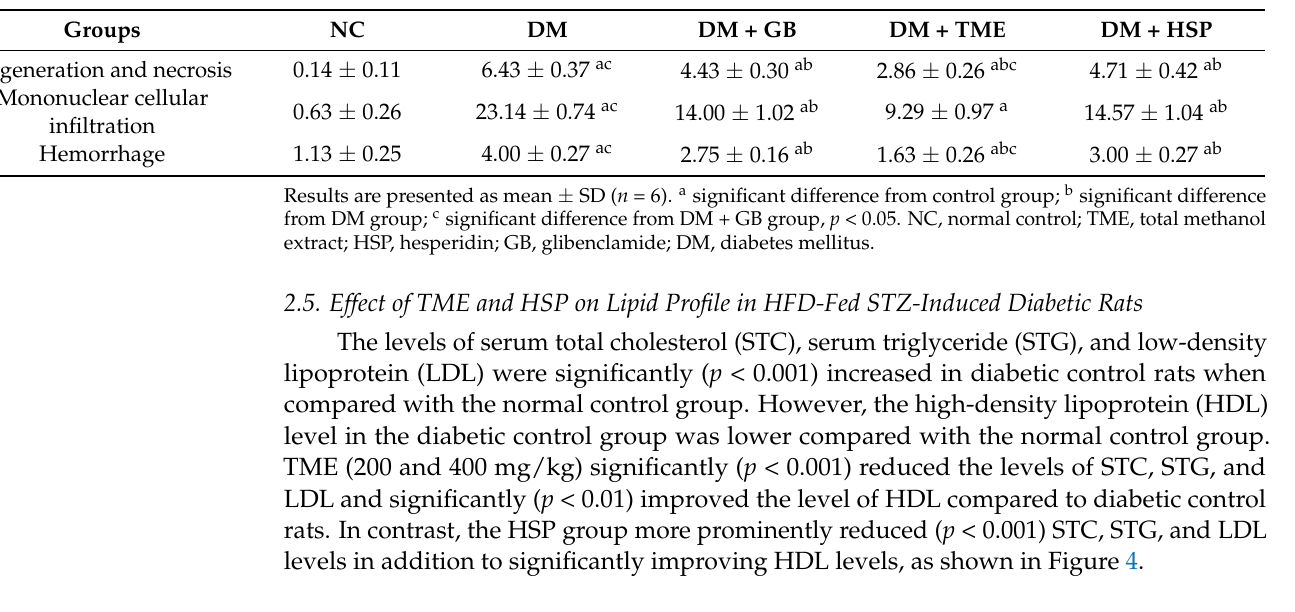
Figure 3. Photomicrographs of control and induced diabetic rat pancreas sections with or without treatment. ( A ) Control rat pancreas (NC) showing normal (exocrine) pancreatic acinar lobules (yellow arrow) and islets of Langerhans (white arrow) embedded within the exocrine portions with vacuolation (brown arrow) and normal intralobular ducts (green arrow). ( B ) Induced diabetic (DM) rat pancreas revealing pathological changes in exocrine acinar lobules with a marked decrease in islets of Langerhans and less apparent cellularity with distorted vacuolation (brown arrow) and blood vessels (blue arrow). ( C ) DM + GB pancreas showing closely packed lobules with improved islets of Langerhans (white arrow), as well as normal interlobular septum ducts (green arrow) and blood vessels (blue arrow), with brown arrows showing normal cellular vacuolation. ( D , E ) Induced diabetic rat pancreas treated with DM + TME 400 mg/kg or DM + 100 mg/kg HSP showing improved endocrine cells (white arrow) of the islets of Langerhans, normal vacuolation (brown arrow), improved intralobular septum ducts (green arrow), and normal blood vessels (blue arrow), compared with the DM group. Scale bar = 50 µ m. NC, normal control; TME, total methanol extract; HSP, hesperidin; GB, glibenclamide; DM, diabetes mellitus. Table 1. Effect of diabetes and different treatments on pancreatic